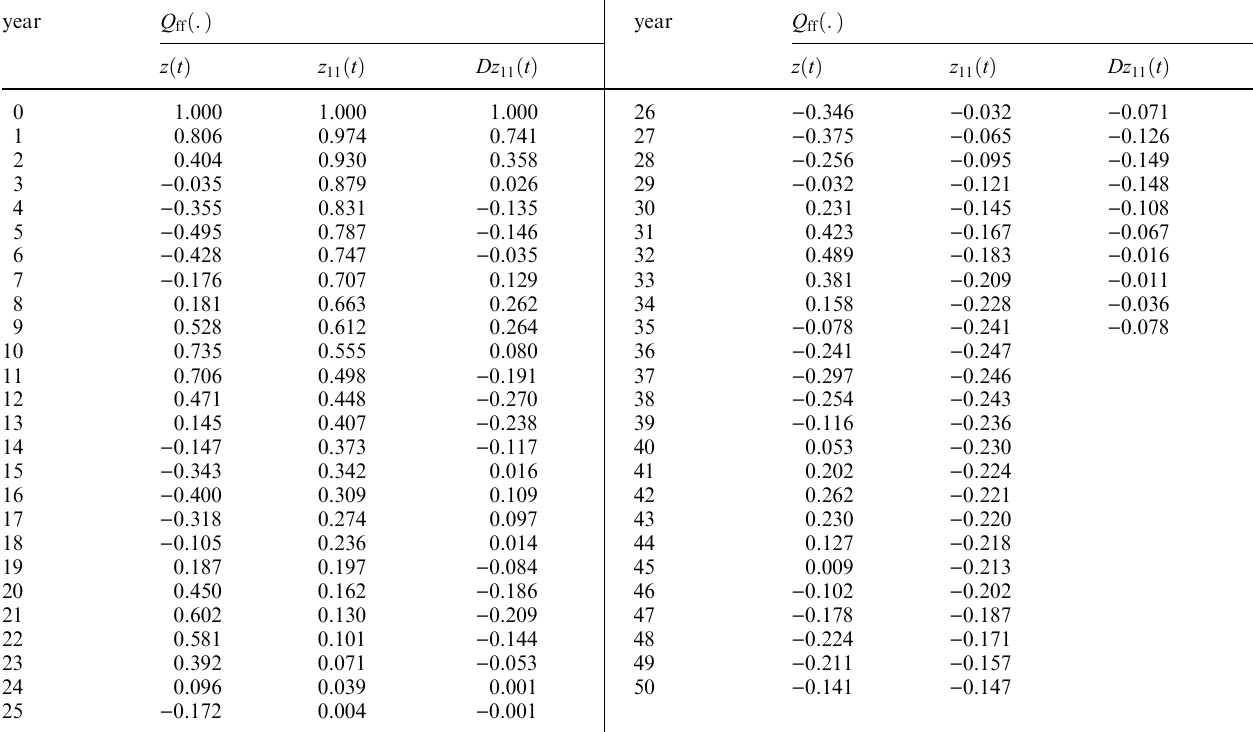
(cid:136) 59 : 25, (cid:137) z 11 (cid:138) (cid:136) 48 : 61, av av